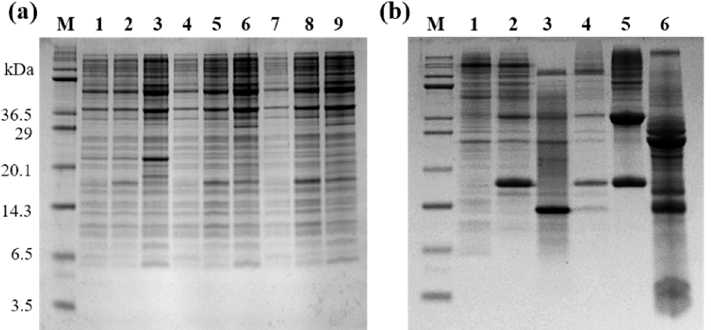
Figure 1. ( a ) Identification of host cells expressing a single insert of YK5 using 12%